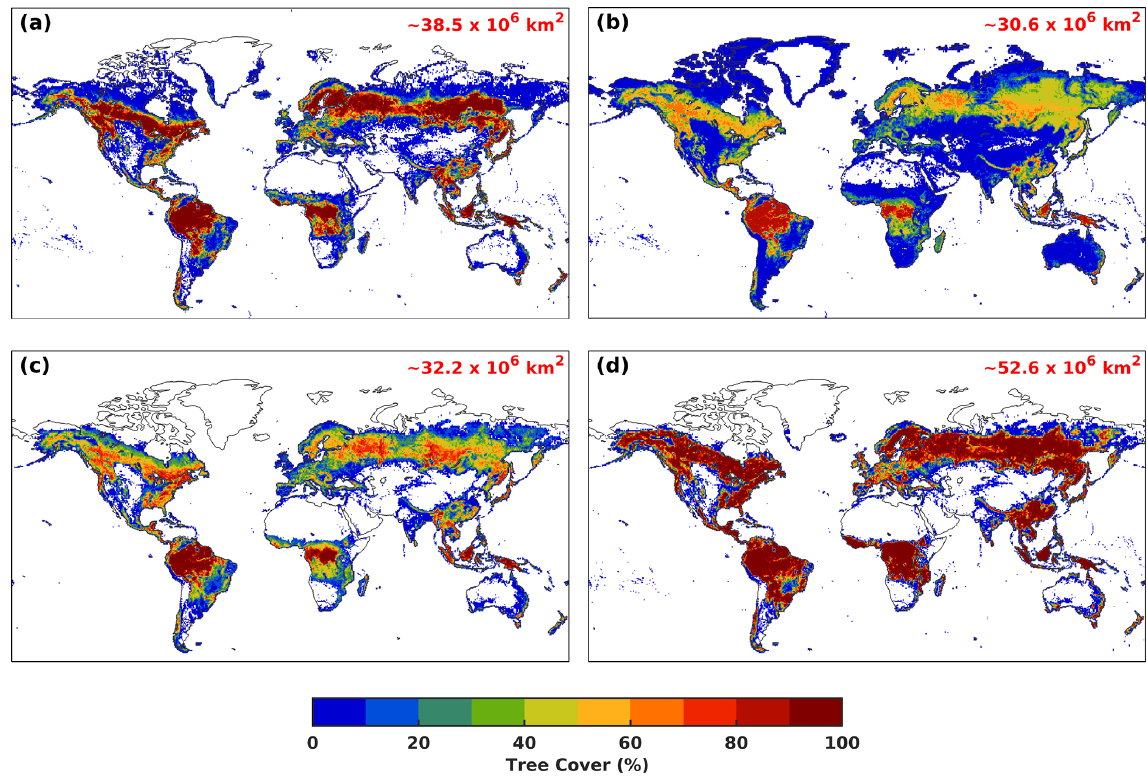
Figure 1. Spatial distribution of the TC for (a) the static land cover map CLM (for the present day) and for the satellite-based datasets ( (b) ESA, (c) GFWMOD, and (d) MODIS) for the year 2001. The corresponding global TC areas are provided